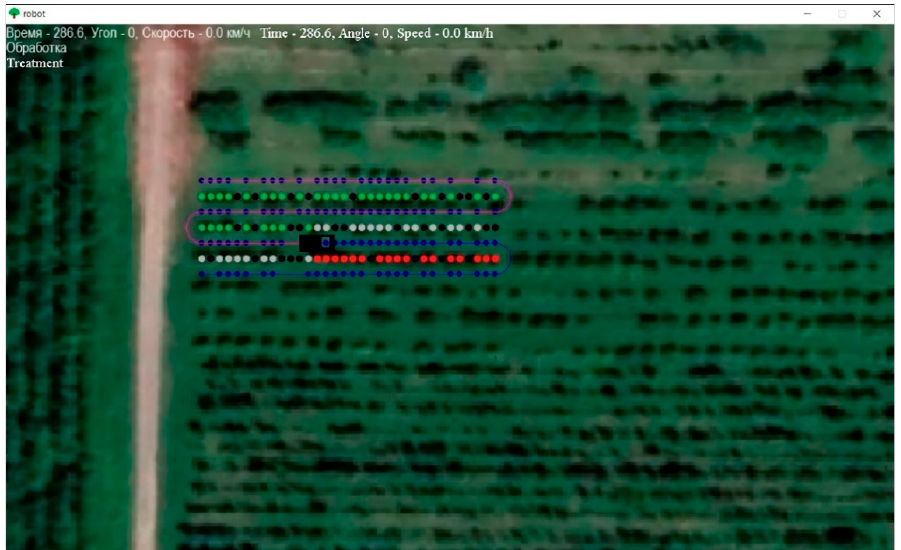
Figure 16. Interface of the software module for building the route of the robotic platform.